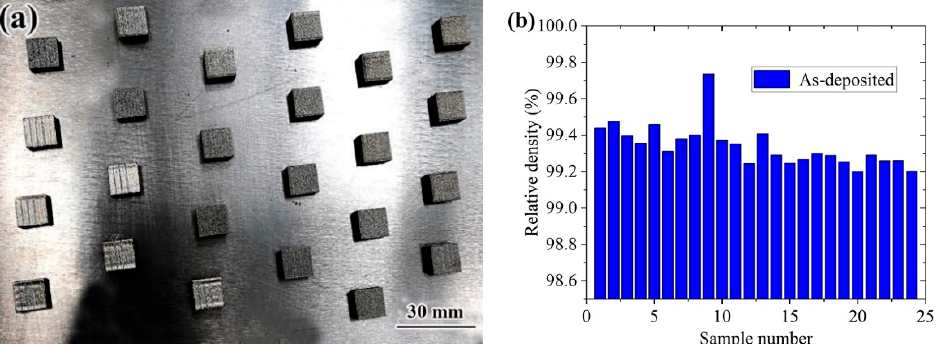
Figure 8. Appearance of the second batch of orthogonal specimens and densification of samples: ( a ) appearance morphology; ( b ) densification of different specimens.